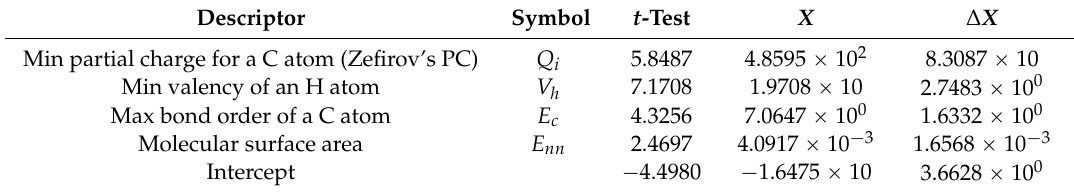
Table 3. The best nonlinear seven descriptors selected using BML method for predicted compound